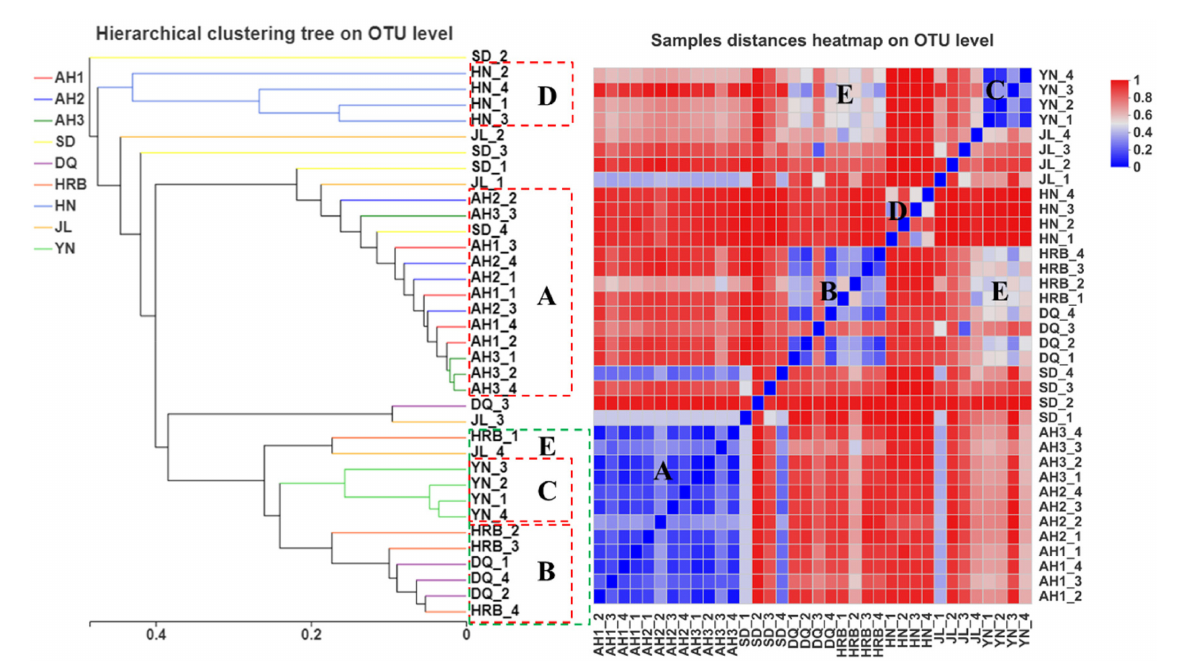
FIGURE4 Bacterial community dissimilarity among samples from nine geographic populations of the hemp flea beetle P. attenuata in China. The picture on the left: analysis of unweighted pair-group method with arithmetic mean (UPGMA) based on hierarchical clustering at the OTU level. The picture on the right: sample distance heatmap analysis at the OTU